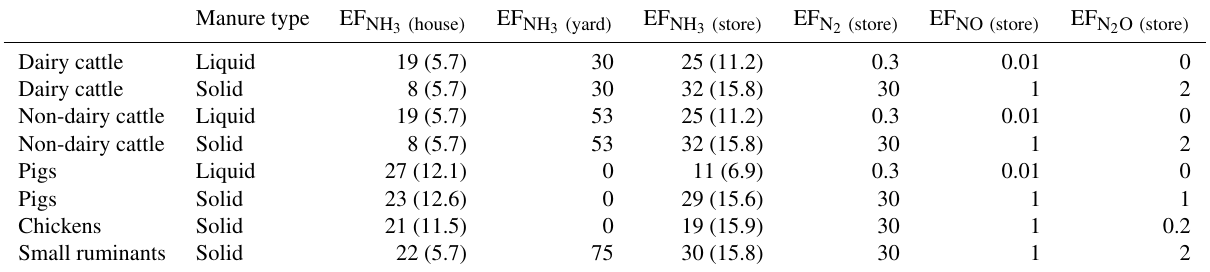
Table 3. Emission factors (EFs) given as a percentage of the TAN content in the manure. EFs for the yard and the other N species come from EMEP/EEA (2019). The other EFs are taken from Sommer et al. (2019). There is no distinction between liquid and solid manure for yard EFs. Numbers in parentheses are the standard deviations given in Sommer et al. (2019) and used for the sensitivity